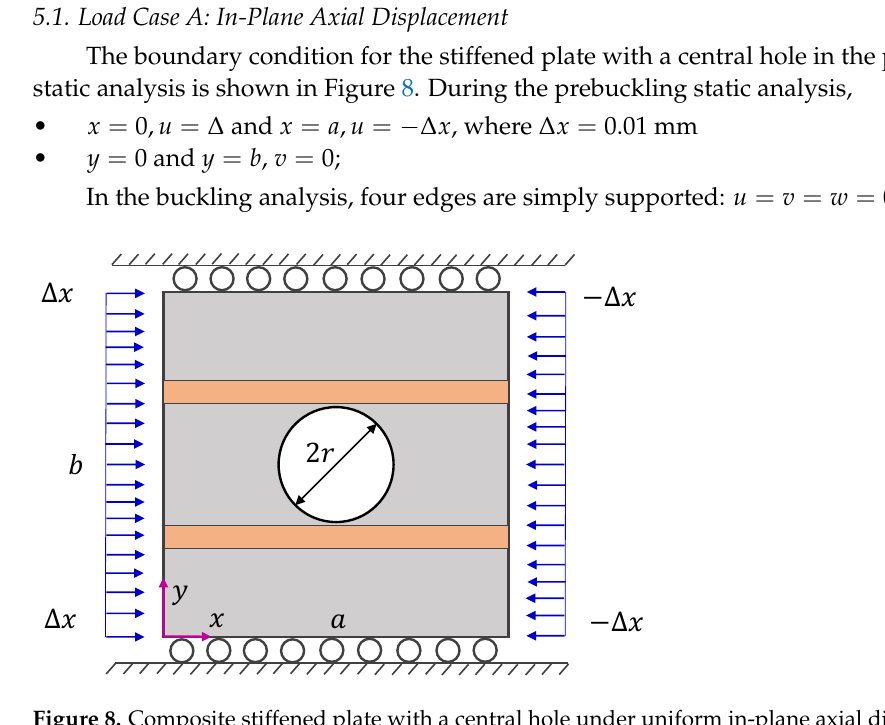
Figure 8. Composite stiffened plate with a central hole under uniform in-plane axial